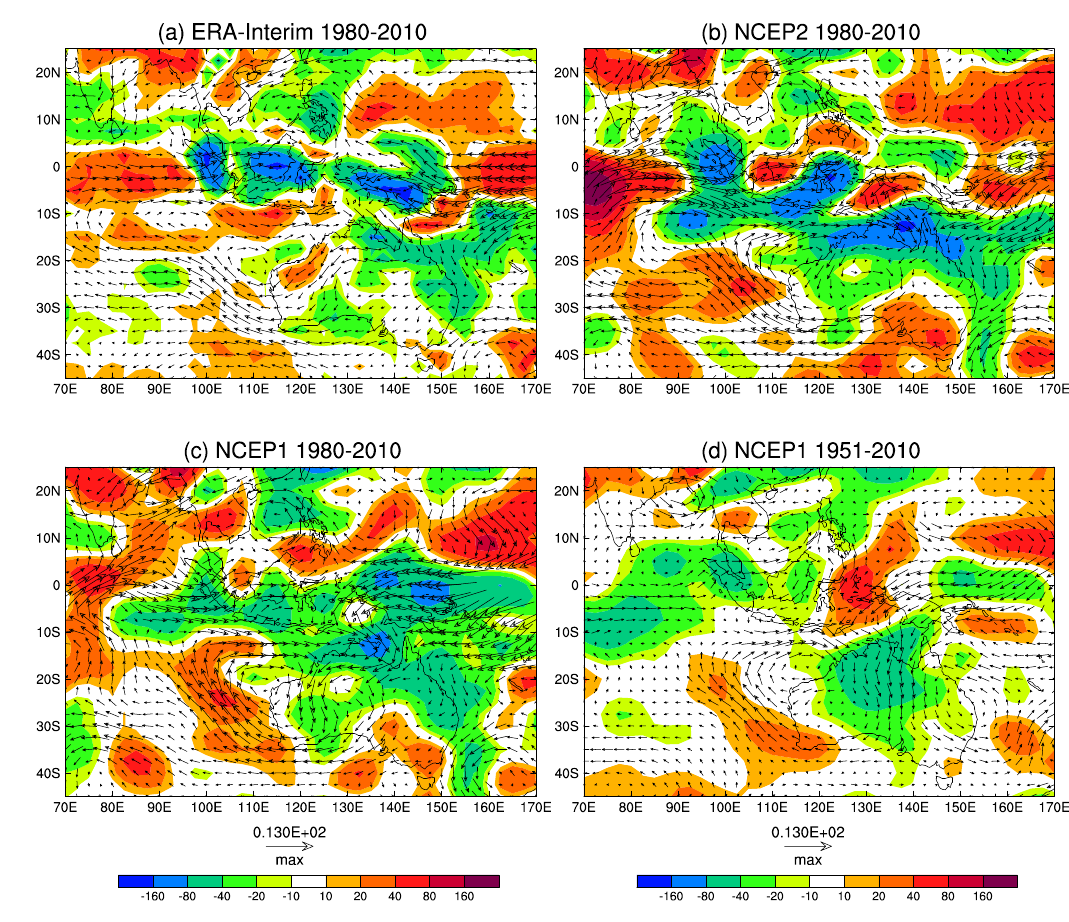
Fig. 19. Trends in 850hPa wind vectors (ms − 1 century − 1 ) and 500hPa vertical velocity (shading, hPaday − 1 century − 1 ) for DJFM from reanalyses, (a) 1979–2010 from ERA-Interim, (b) 1980–2010 from NCEP-DOE Reanalysis 2, (c) 1980–2010 from NCEP/NCAR